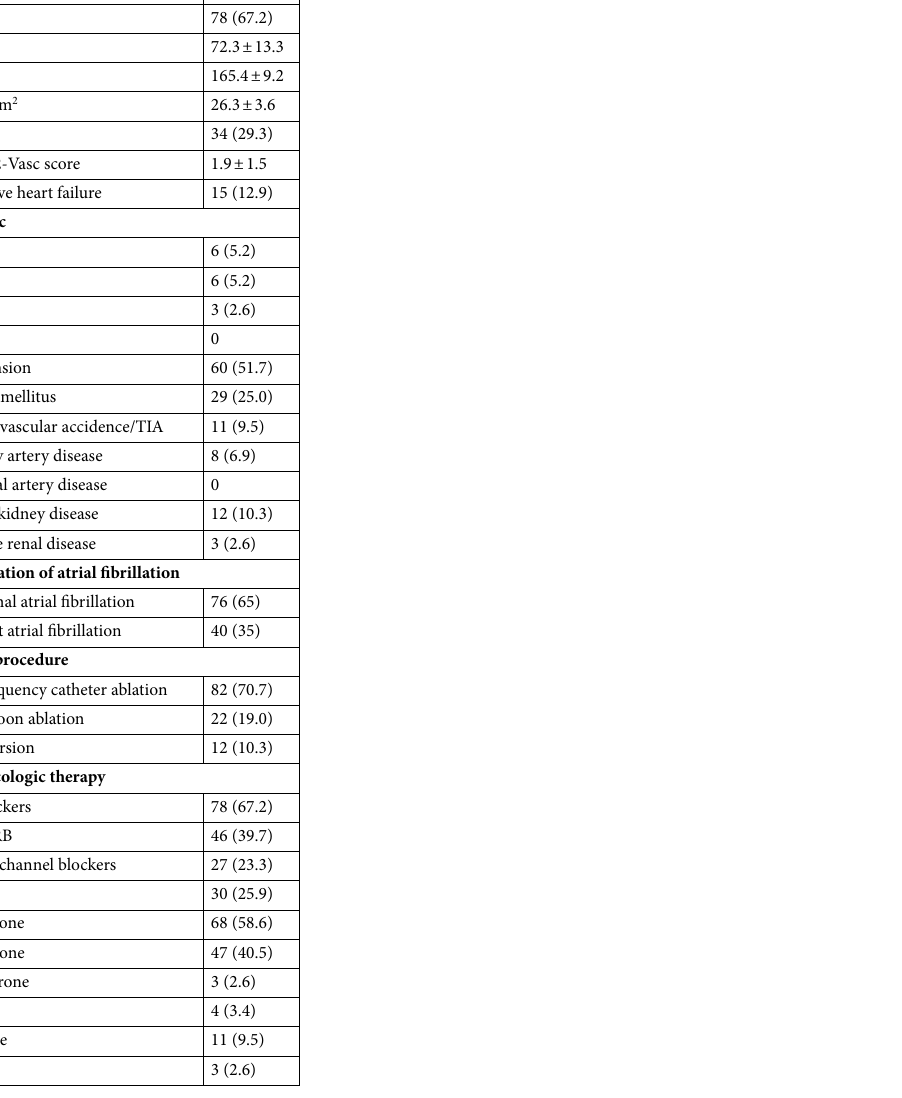
Table 1. Baseline characteristics of study